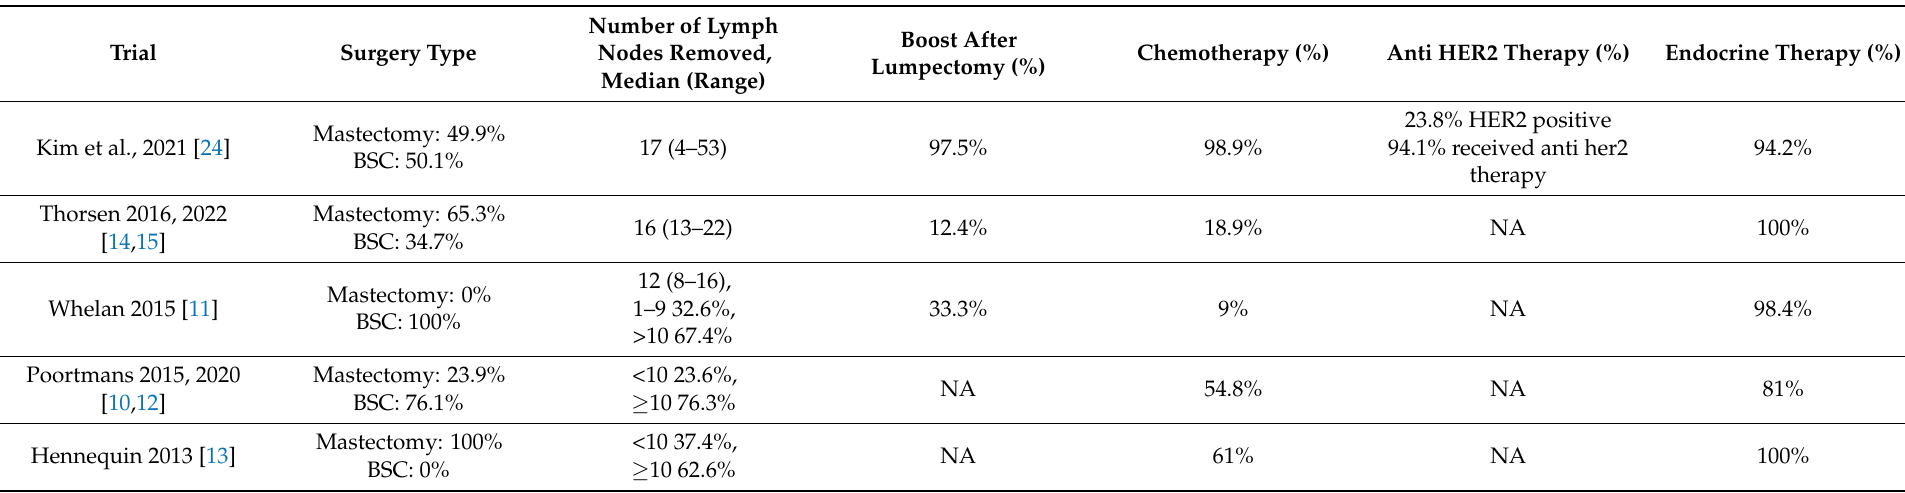
Table 2. Data on the local and systemic from included